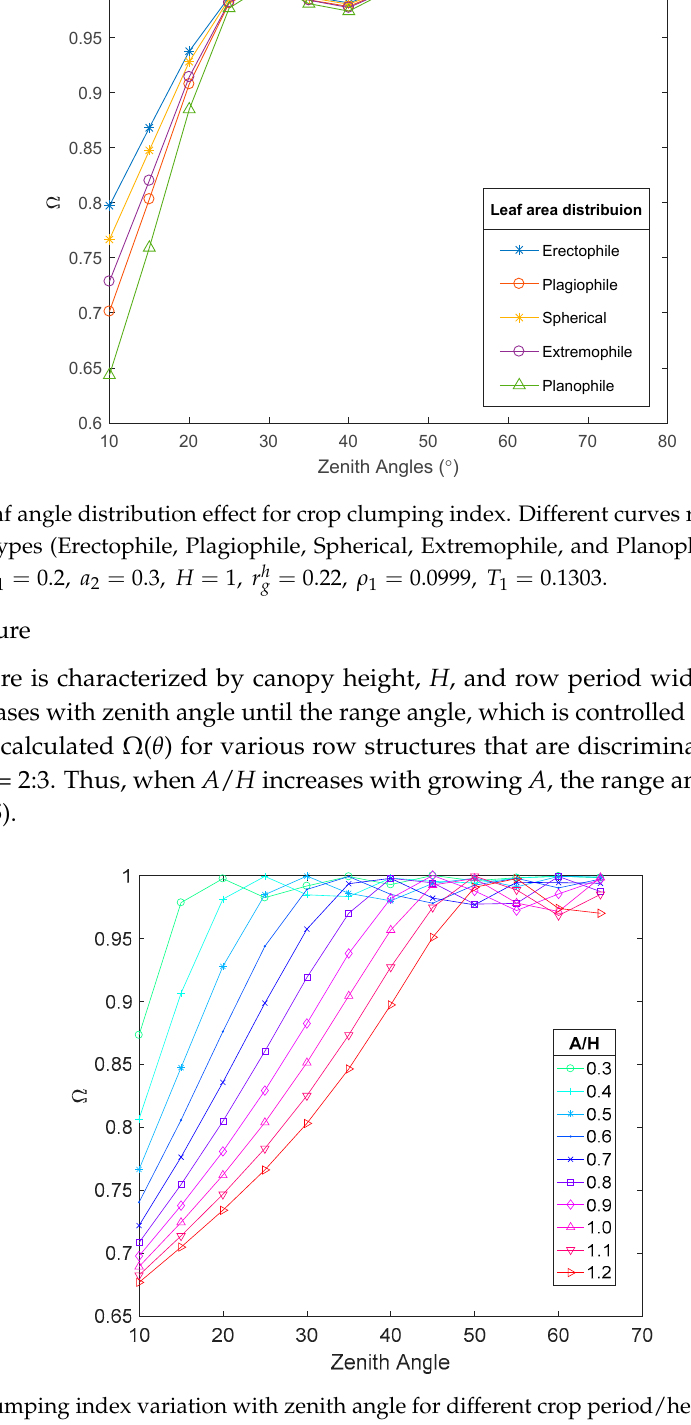
Figure 14. Clumping index variation with zenith angle for different crop period/height ( A/H ) ratios = 2:3, =/ 1 H a a , intra-row LAI = 3. (different curves). Simulation parameters: 1 2